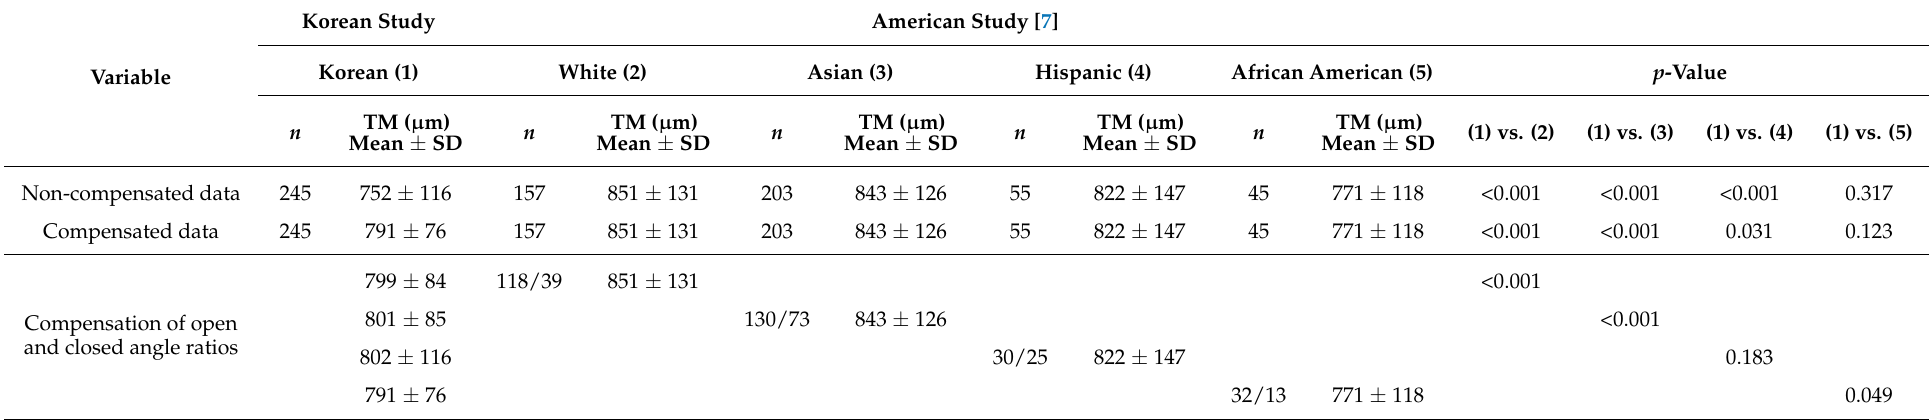
Table 4. Comparison of trabecular meshwork height among various